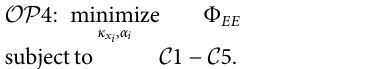
algorithm. From ( Eqs 19c – 19e ), we either have λ 1 = 0 or